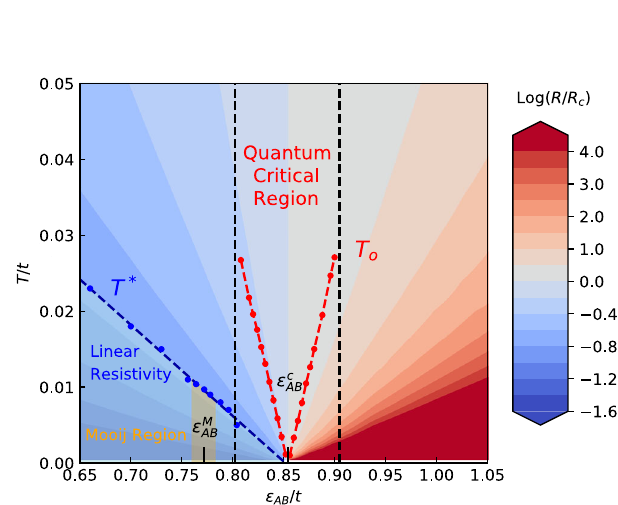
Fig.3|Scalinganalysisforbothexperimentalandtheoreticalresults.a Scaling analysis is performed for the experimental resistance curves corresponding to Fig.1a, within 0.412V/nm ≤ E ≤ 0.450V/nm, revealing near-perfect agreement with thetheoreticalscalingfunction(redline),withnoadjustableparameters. b Critical resistance R c ~ T − x onexperimentsdisplaysbehaviorconsistentwiththetheoretical